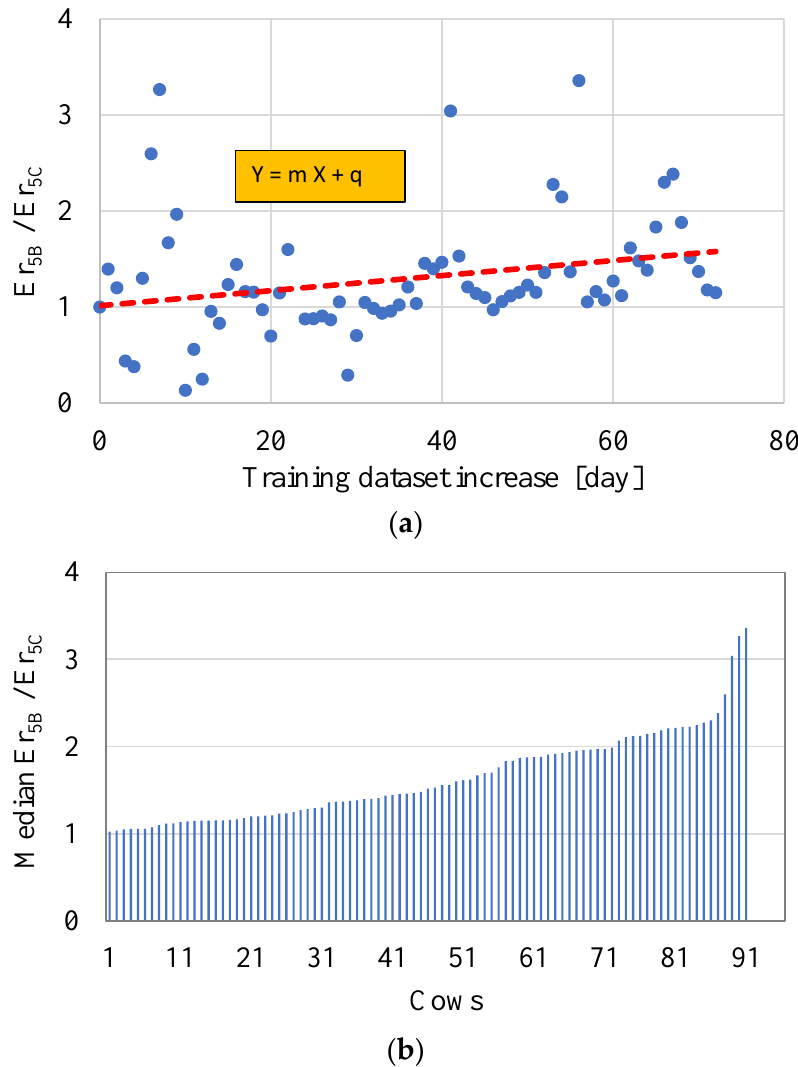
Figure 12. Analysis of the results on the ratio Er 5B /Er 5C . ( a ) Evolution of the ratio for the cow #248 with training dataset increase. ( b ) Median ratios in ascending order for the 91 cows.